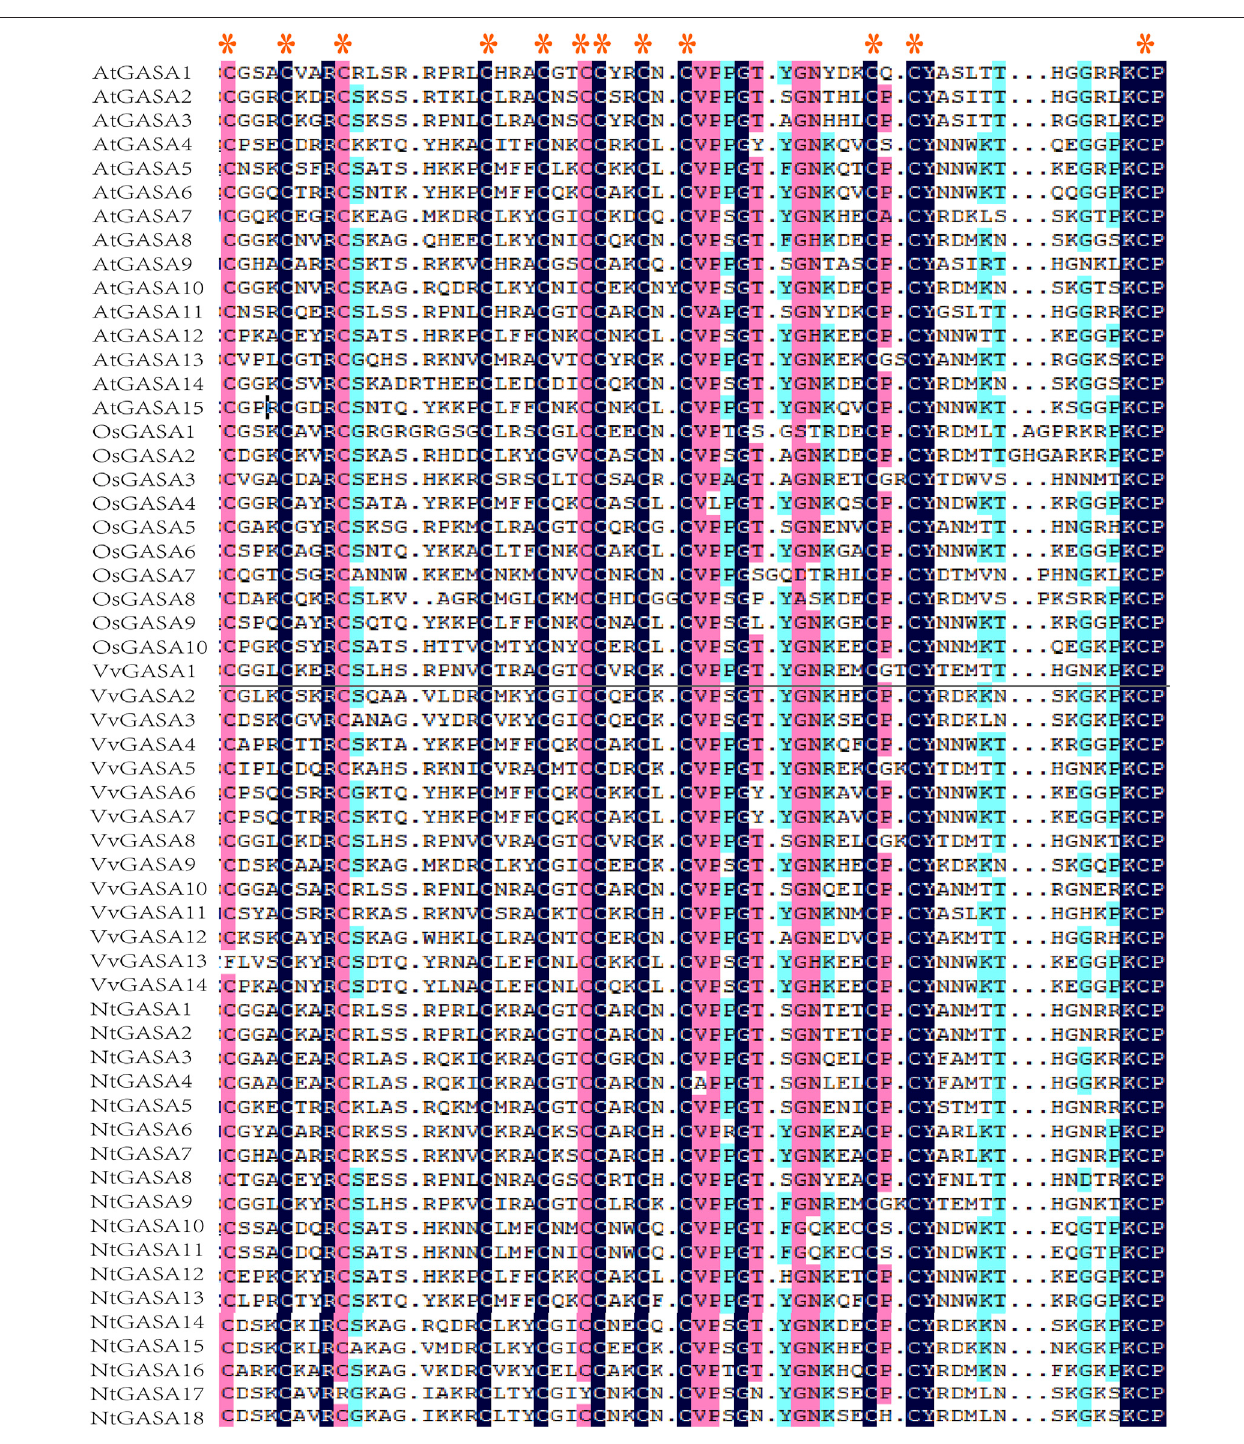
FIGURE 5 | Alignment of the GASA domain from AtGASA, OsGASA, VvGASA, and NtGASA proteins, red asterisk represented their conserved cysteines.